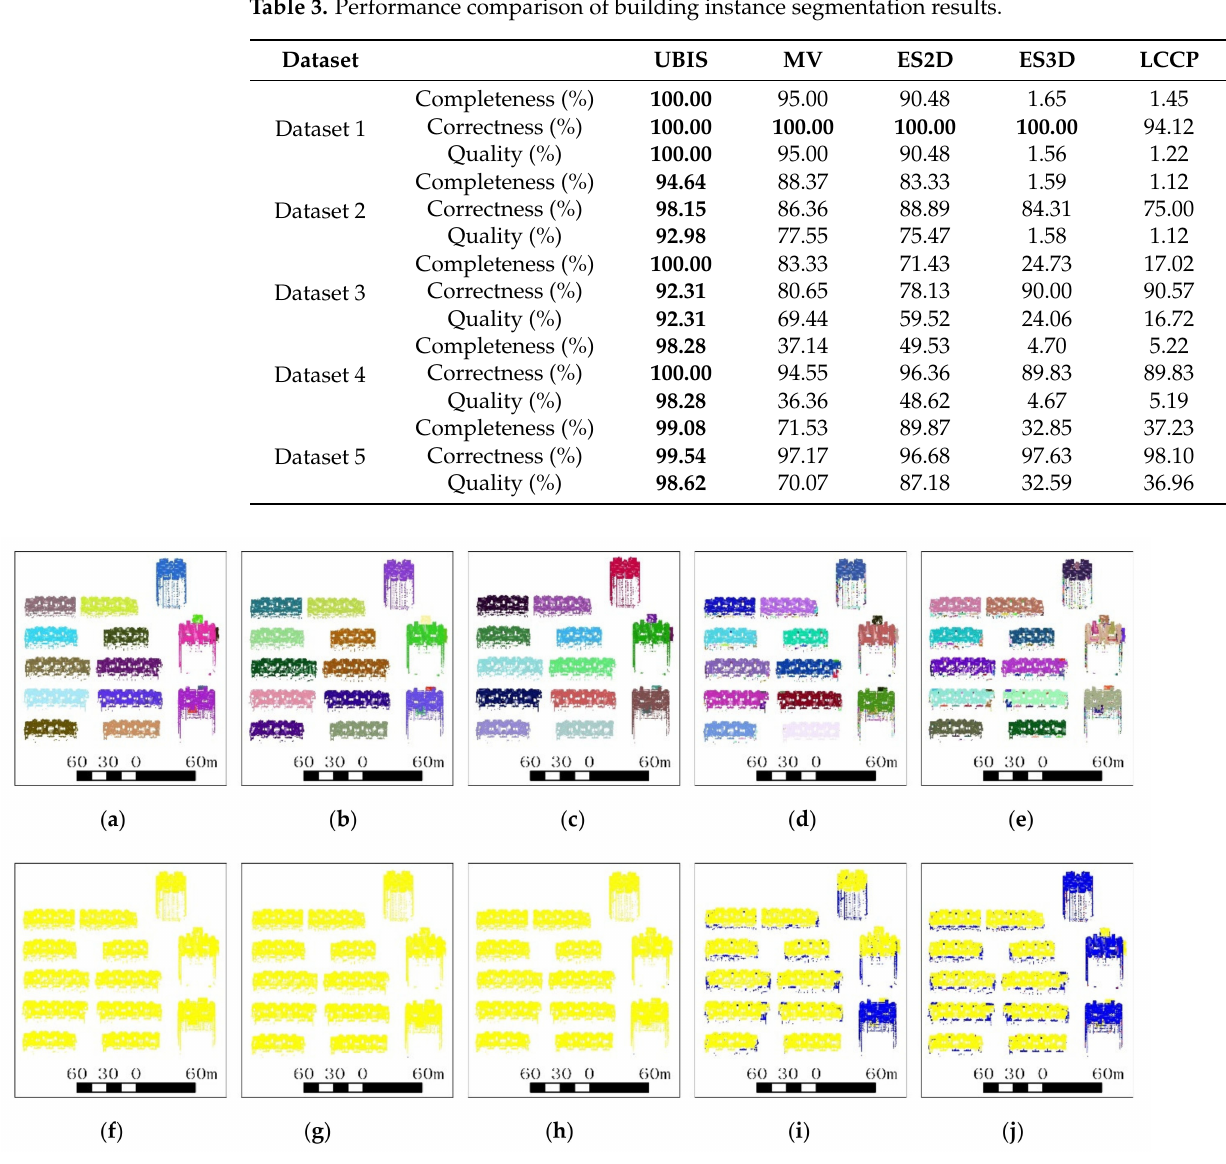
Figure 13. Building instance segmentation result comparison of dataset 1: ( a ) Result of the UBIS method; ( b ) result of the MV method; ( c ) result of the two-dimensional Euclidean-based segmentation method (ES2D) method; ( d ) result of the three-dimensional Euclidean-based segmentation method (ES3D) method; ( e ) result of the LCCP method; ( f ) the main differences between the result of the UBIS method and the ground truth; ( g ) the main differences between the result of the moving window (MV) method and the ground truth; ( h ) the main differences between the result of the ES2D method and the ground truth; ( i ) the main differences between the result of the ES3D method and the ground truth; ( j ) the main differences between the result of the LCCP method and the ground